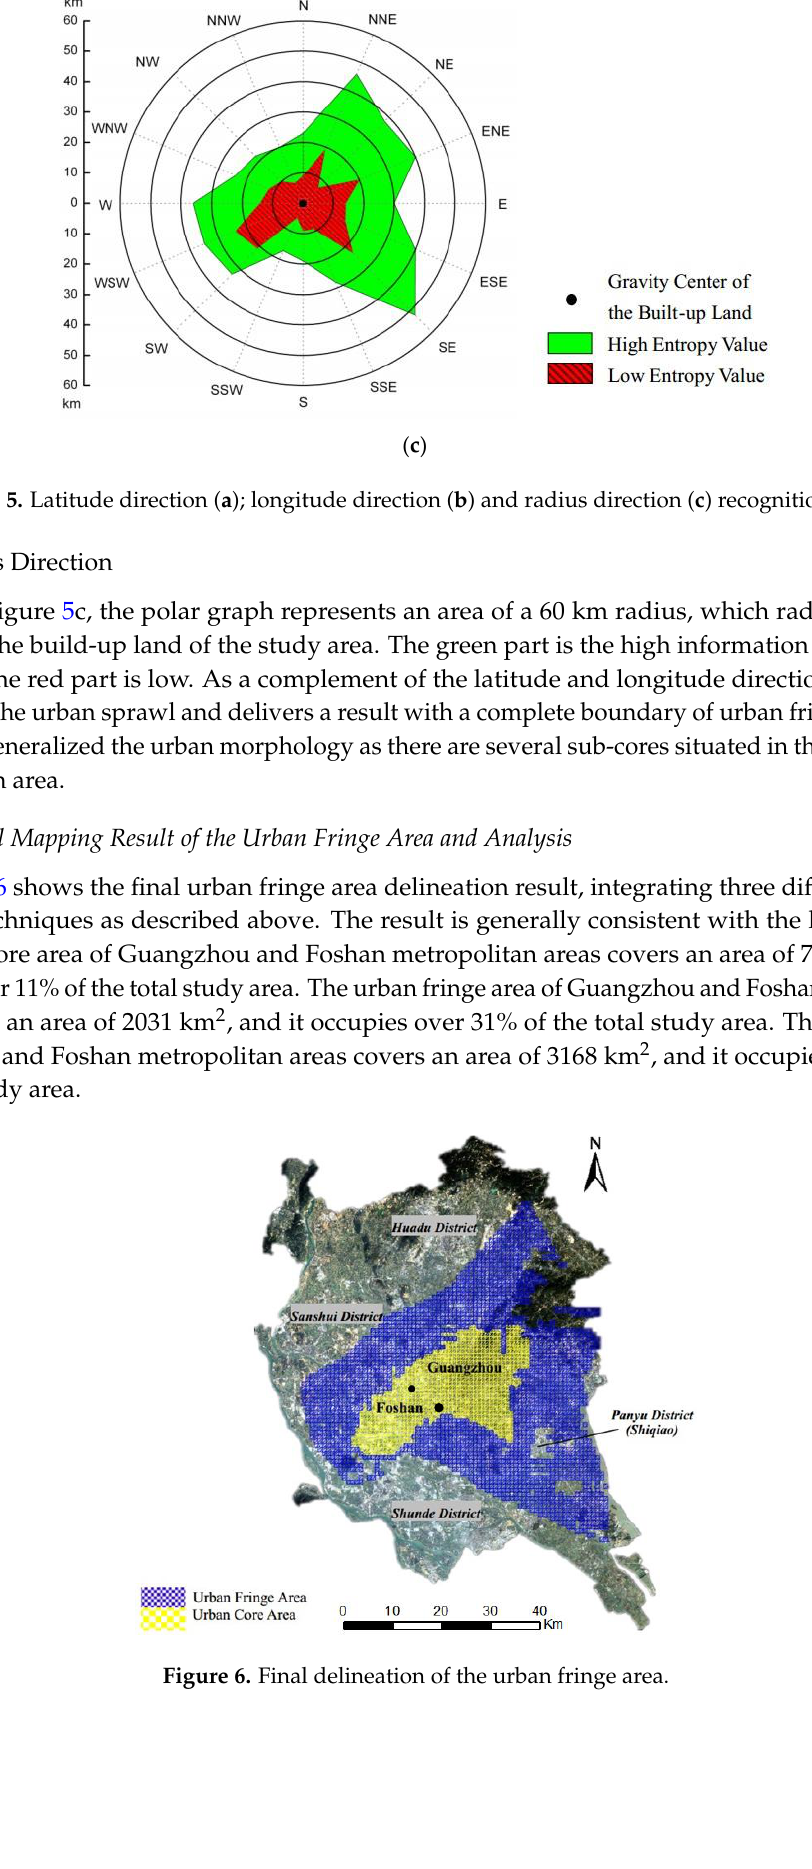
Figure 6. Final delineation of the urban fringe area.